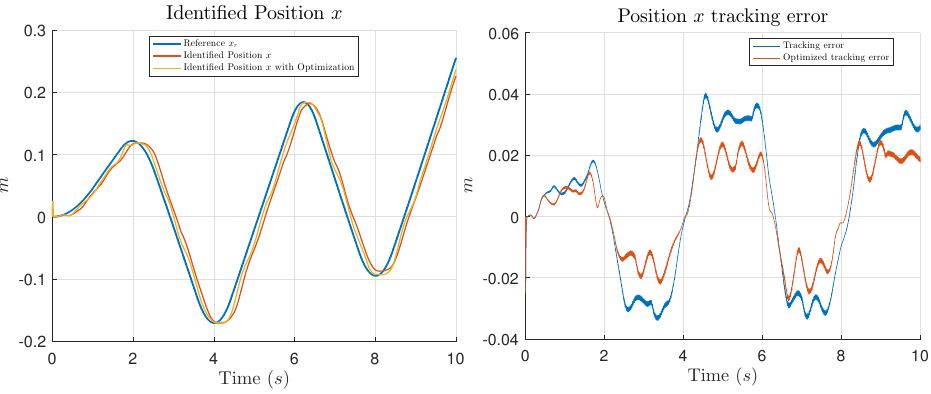
Figure 9. Tracking of x position ( left ) and error comparison ( right ) for the experimental test 1.